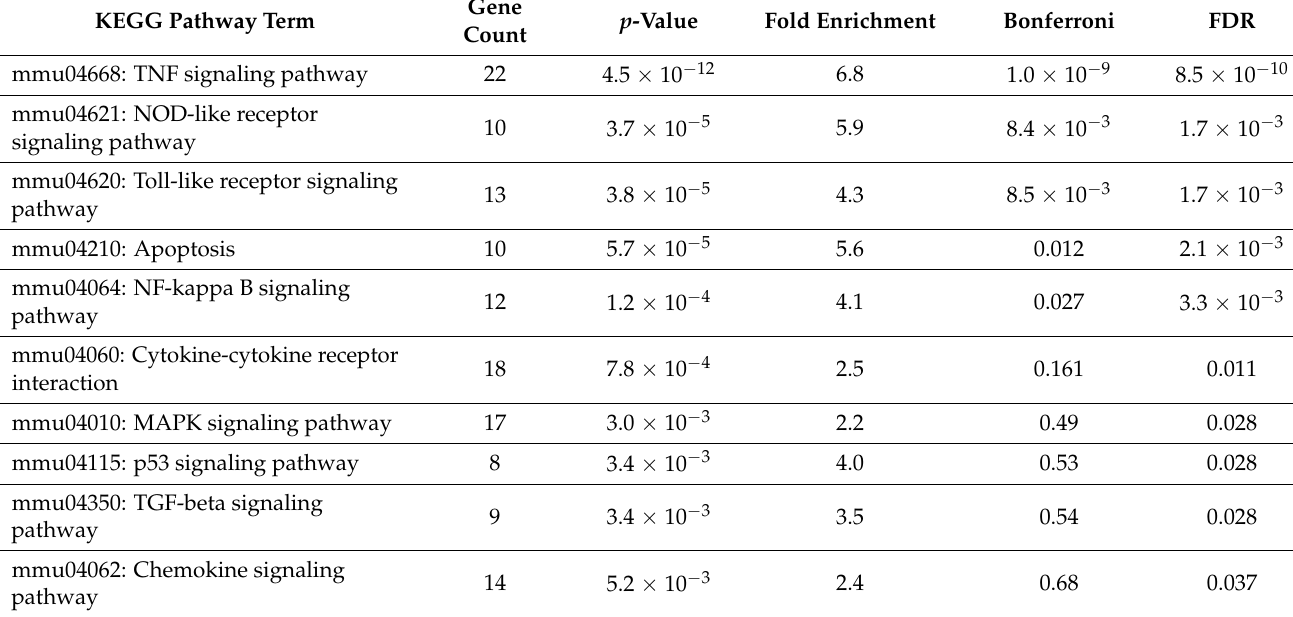
Table 1. Top inflammation-related enriched KEGG pathways using top 500 DEGs from CapEC.